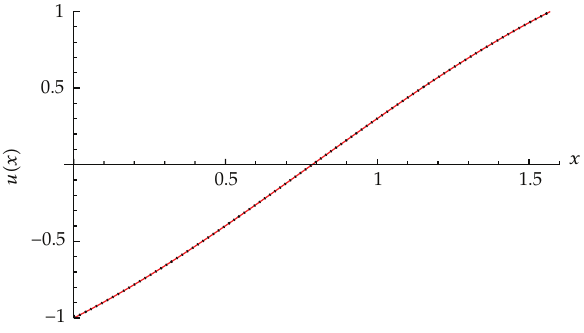
Figure 11: Solutions of (cid:4) 4.13 (cid:5) and (cid:4) 4.14 (cid:5) . Dotted line: the 5th-order approximate HAM solution at (cid:2) (cid:9) − 1 and solid line: the exact